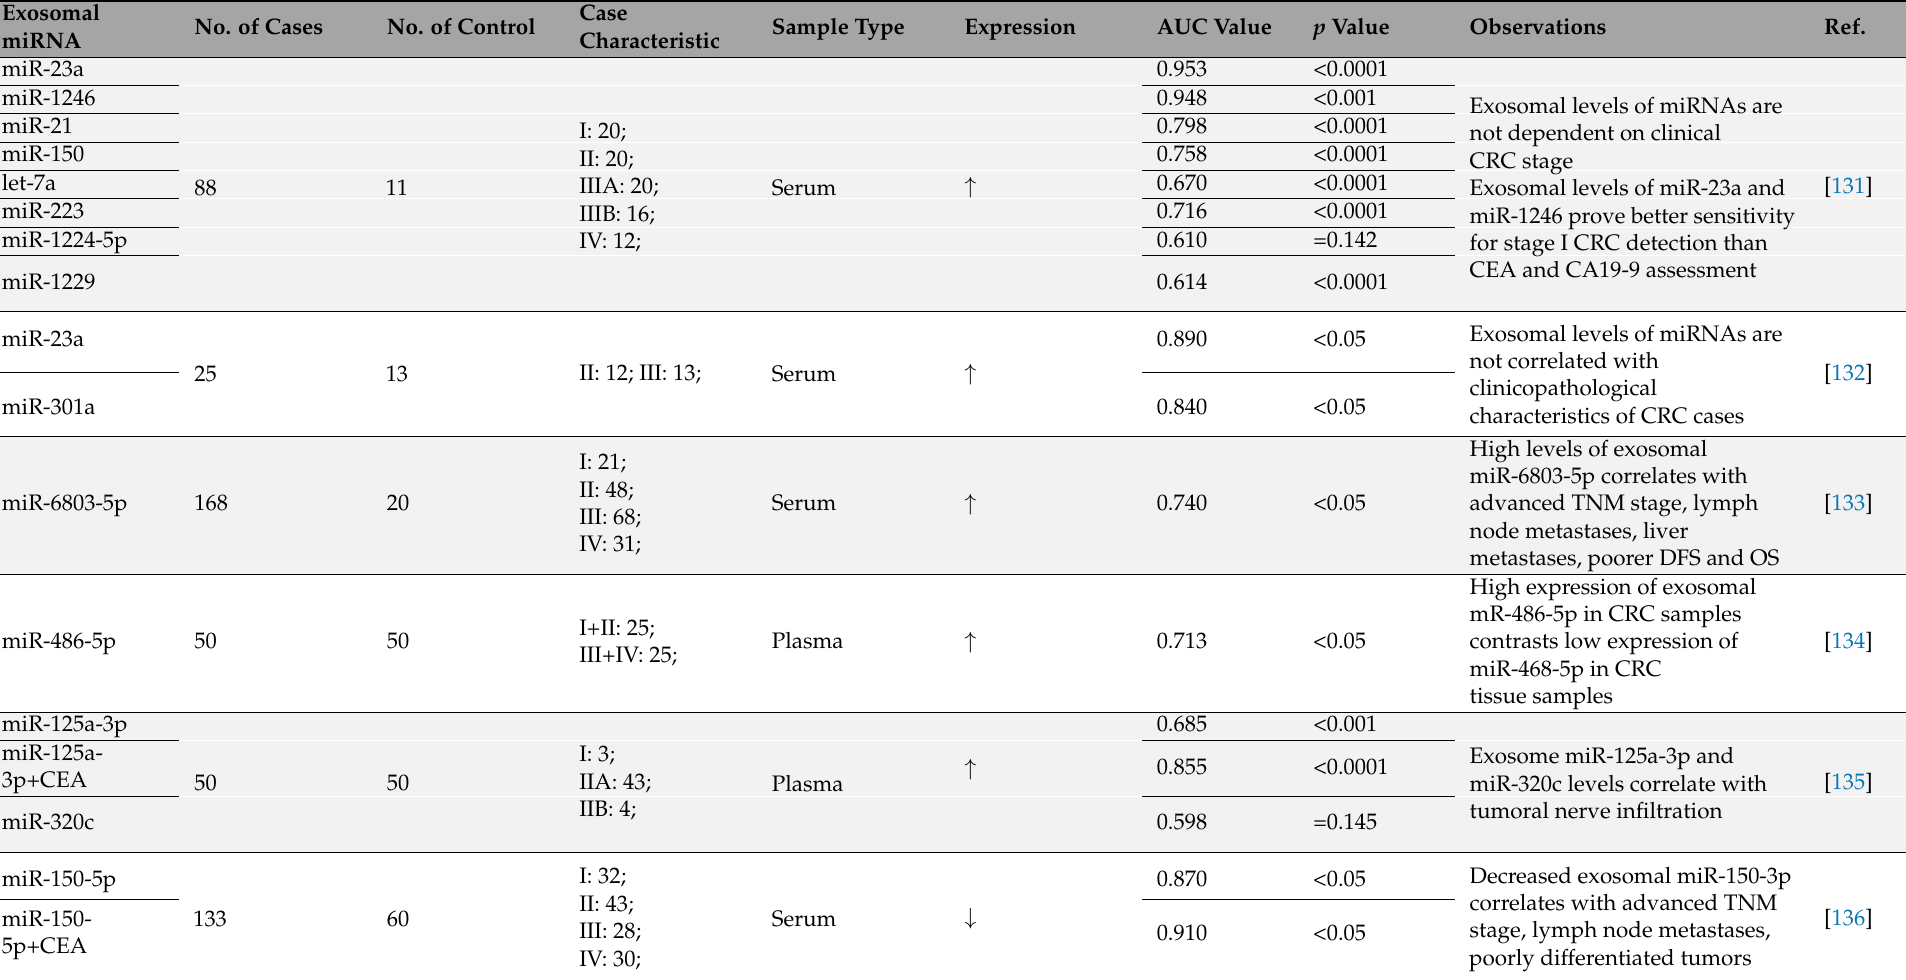
Table 4. Outline of blood exosomal molecules with confirmed validity in CRC screening and early